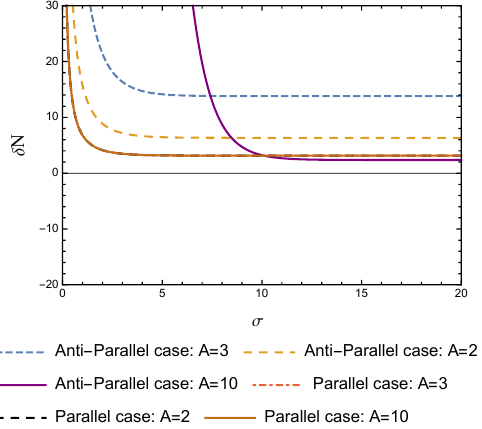
Figure 21 . Parallel and Anti-parallel motions in (1 + 1) dimensions with thermal background: δ N Vs σ plot with ∆ E = 1 , α = 0 . 707 a B